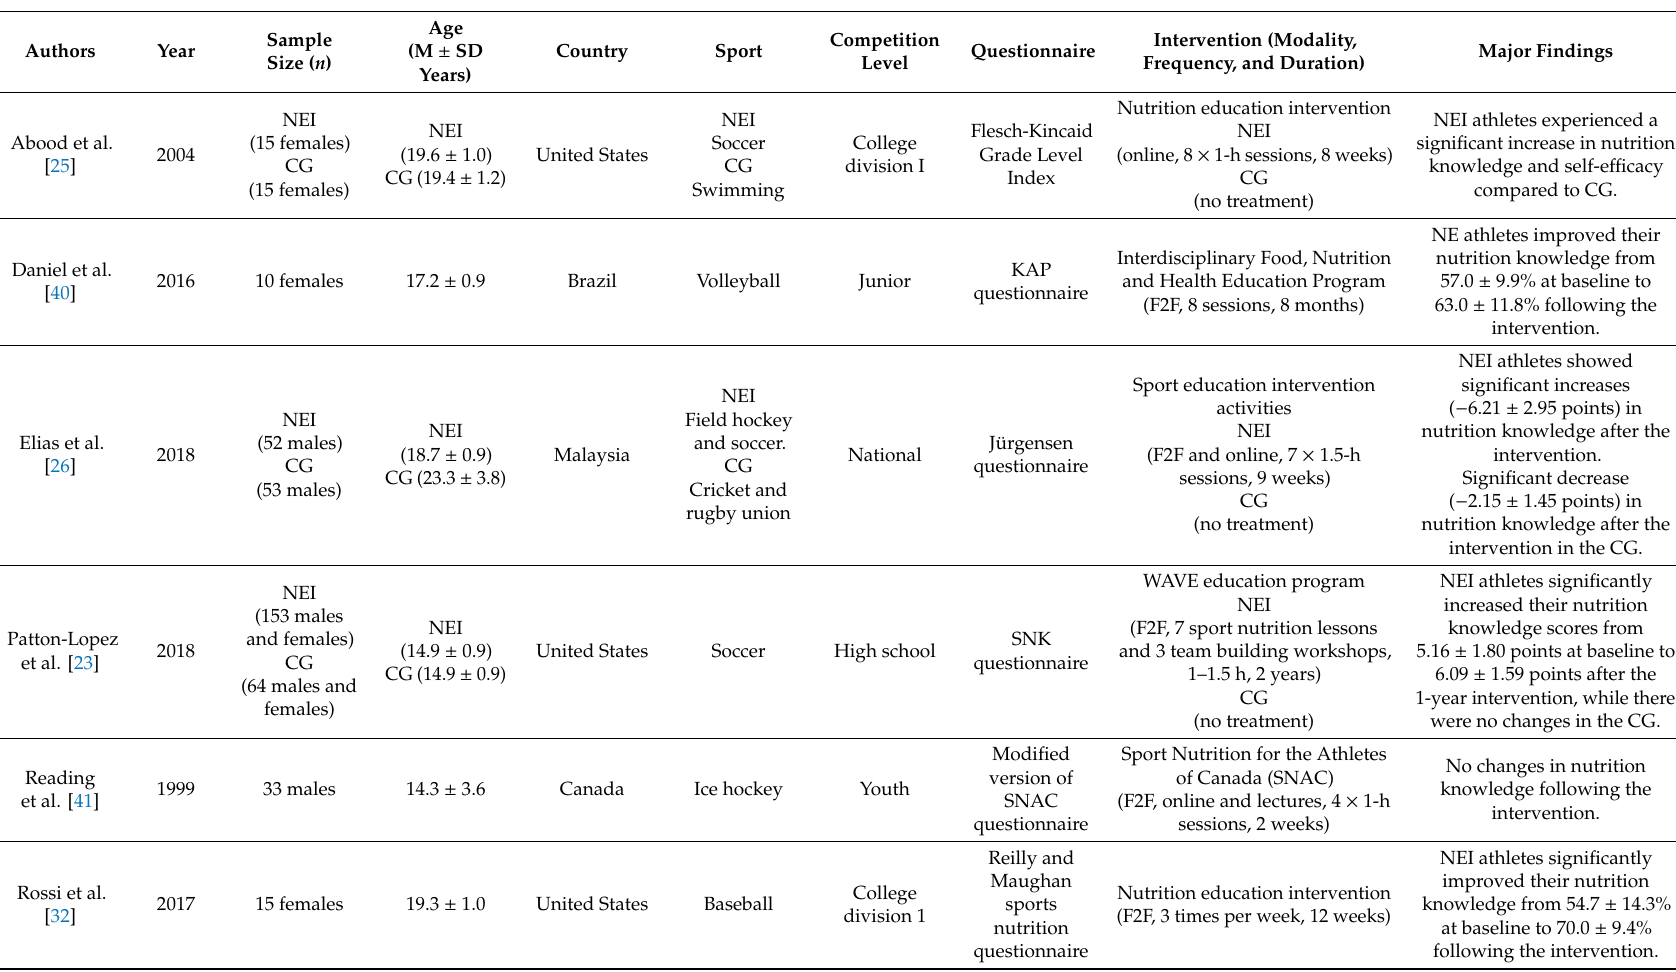
Table 2. Characteristics and major findings of the studies analyzing the e ff ect of nutrition education interventions on nutrition knowledge in team sport